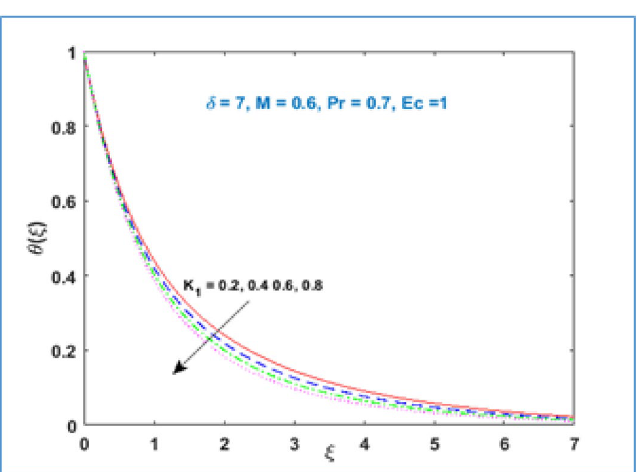
Figure 8. θ(ξ) versus K 1 .